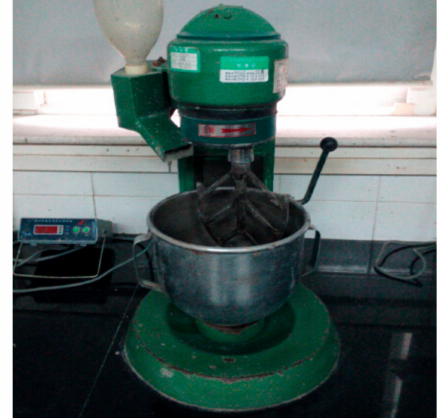
Figure 1. Cement mortar mixer.